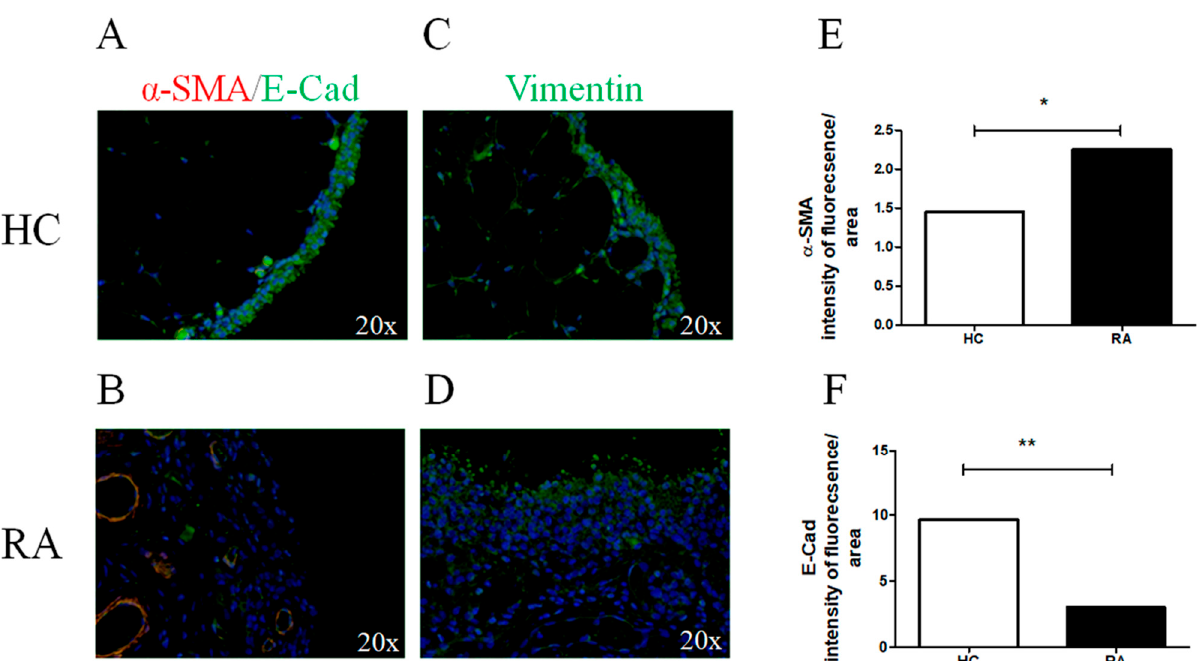
Figure 1. Myofibroblast markers expression in synovial tissue of patients with RA and HCs. ( A , B ) α -SMA (red) and E-Cad (green) immunofluorescence (IF) of HC ( A ) and RA ( B ) synovial tissue; ( C , D ) vimentin (green) IF of HC ( C ) and RA ( D ) synovial tissue. In RA synovial tissue, the intensity of fluorescence of α -SMA ( E ) was increased, whereas E-Cad ( F ) was decreased when compared to HCs. The histogram showed median for each synovial tissue (* = p = 0.01; ** = p = 0.001). Original magnification ×20.